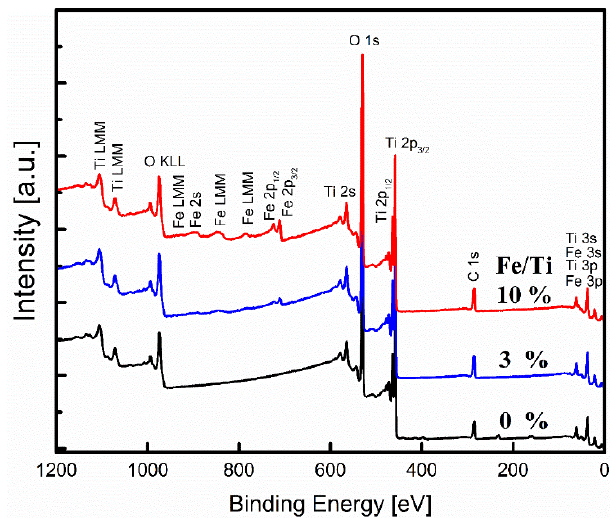
Figure 8. Survey scan spectra of pure TiO 2 and Fe-doped nanoparticles.